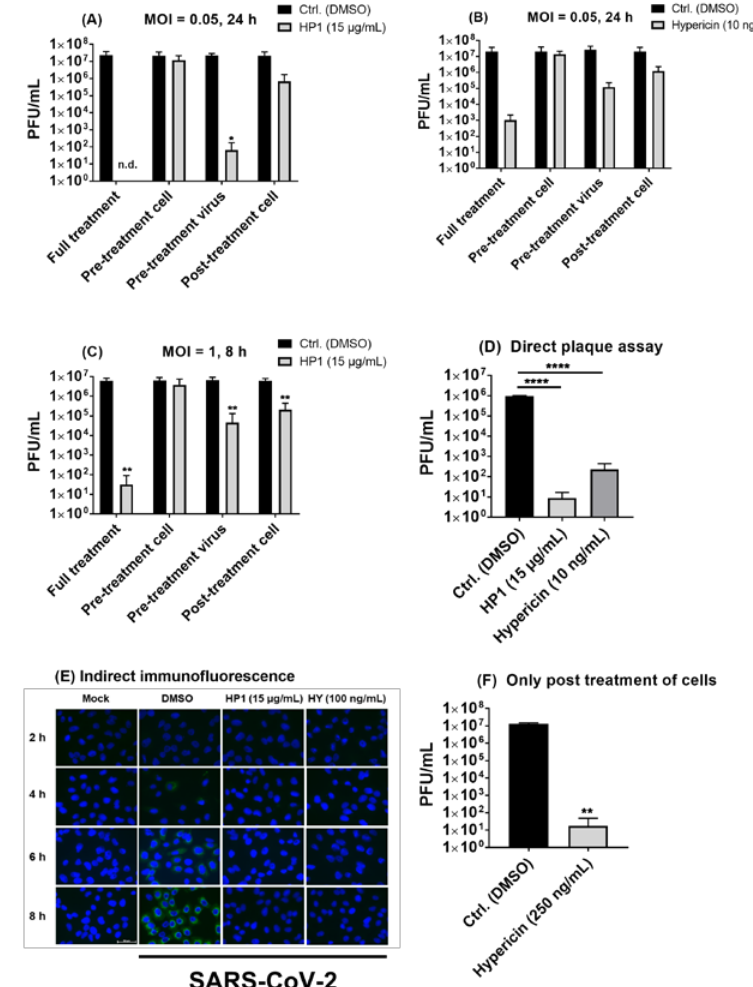
Figure 6. Hypericum perforatum (HP1) and hypericin (HY) carry direct SARS-CoV-2 virus-blocking activities. ( A – C ) Vero cells were seeded overnight. The next day, different treatment protocols with HP1 or hypericin were applied. The treatment conditions included (i) only pre-treatment of cells (for 1 h at 37 °C) in infection-DMEM containing solvent control (DMSO) or HP1 or hypericin, (ii) only pre-treatment of SARS-CoV-2 (for 1 h at room temperature) in infection-PBS containing solvent control or HP1 or hypericin, or (iii) only post-treatment of cells after infection in infection-DMEM (at 37 °C) containing solvent control or HP1 or hypericin. As control, the combined treatment protocol of pre-treatment of cells and SARS-CoV-2 and post-treatment of cells was included as well (Full treatment). The SARS-CoV-2 infection was conducted at MOI of 0.05 or 1, as the total length of the infection experiment was ( A , B ) 24 h or ( C ) 8 h, respectively. ( A – C ) After the depicted length of experiments, virus supernatants were harvested, virus titration was done with plaque assay, results are shown as PFU/mL (means and s.d.), and two-way ANOVA with Sidak’s multiple comparisons was done by comparing each value to its respective solvent control. ( D ) SARS-CoV-2 was incubated